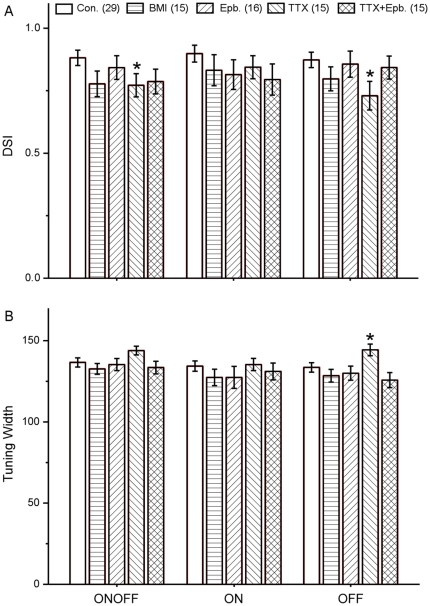
Comparison of DSI and turning width.Population data comparing direction selective index (A) and the width of direction tuning curves (B) of DSGCs in control retina and retinas treated with BMI, Epb, TTX and the mixture of Epb and TTX. Data were analyzed using one way ANOVA, and presented in AVG±SE. *: p<0.05. Cell number is described in parentheses.